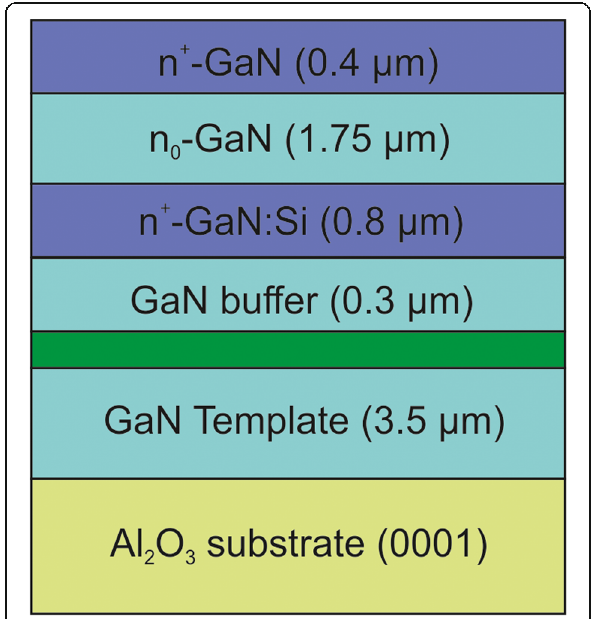
Fig. 5 The 7-layer model used to simulate the IR reflectance spectra of the investigated n + /n 0 /n + -GaN structure. An additional layer ( green ) is thin interface layer between GaN template and the investigated GaN